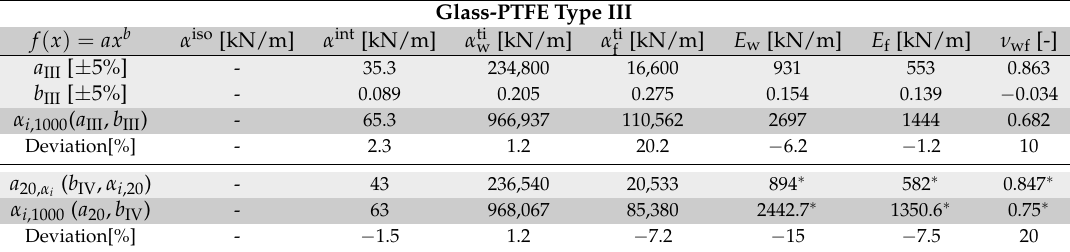
Table 7. Extrapolated material parameters and the computed coefficients of the estimation function using glass-PTFE III data. Deviation is computed as relative difference of an estimated parameter from its original value in Tables 4 and 5.